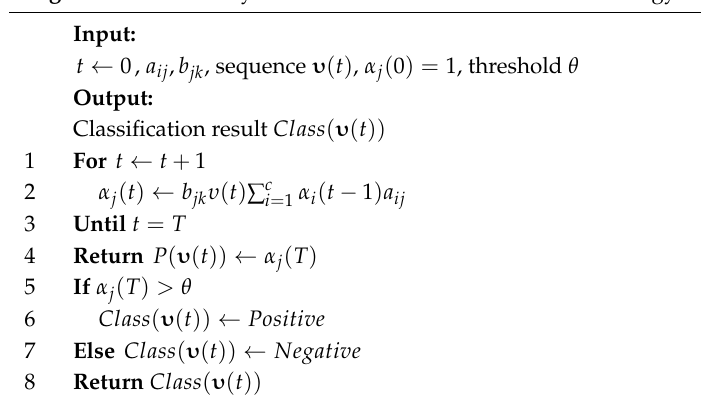
Algorithm 2. Anomaly detection based on the estimation